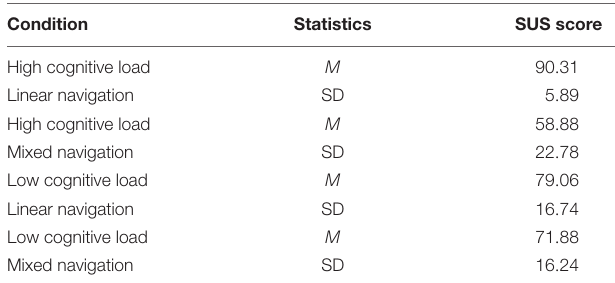
TABLE 4 | Usability scores in different